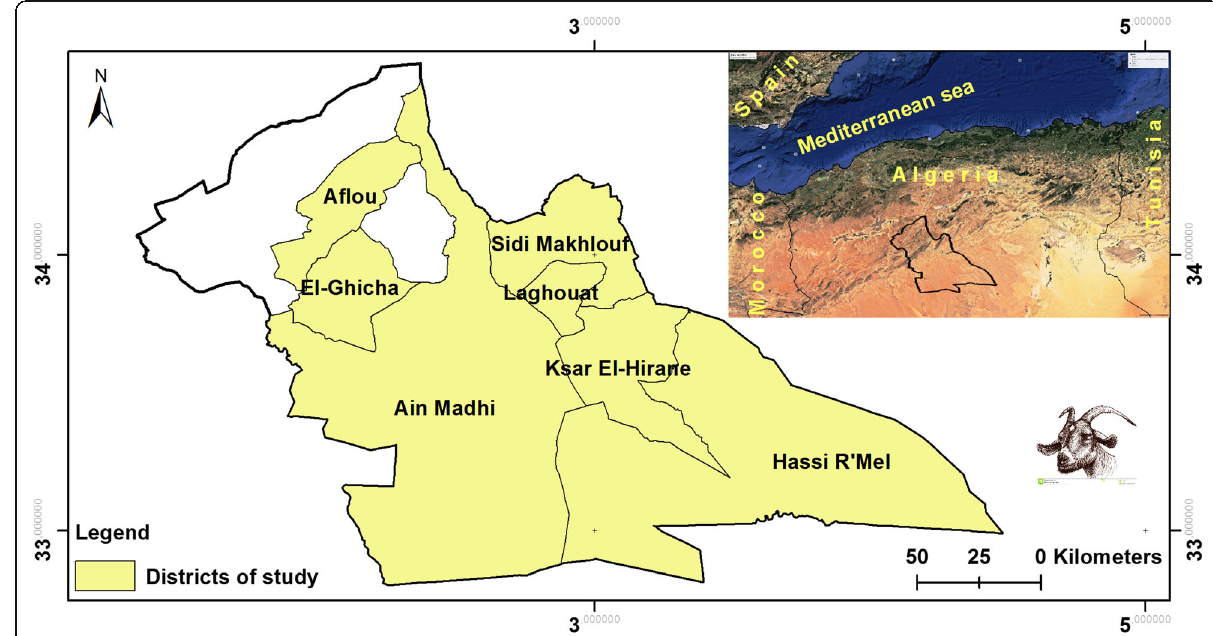
Figure 1 Study area of Laghouat, Algeria, indicating the districts covered by the